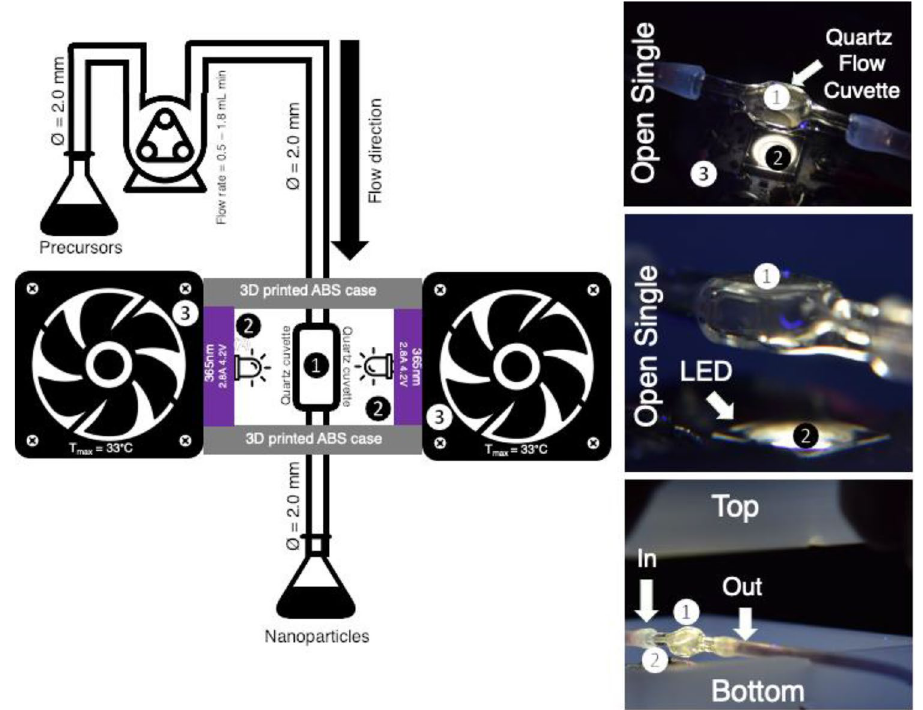
Figure 1. Design of nanoparticle flow synthesis system. Left: Schematic representation for the Nanoparticle Flow Synthesis System (NPFloSS). Right: Actual pictures of the NPFloSS highlighting some key components of the design. The NPFloSS is composed of three simple main components: (1) a UV-transparent quartz cell with connected by tubing, (2) two 365 nm UVA LEDs as a photon source, and (3) two heat sinks for heat management. The part list information and assembly instructions for this system are available at no cost in the ESI of the